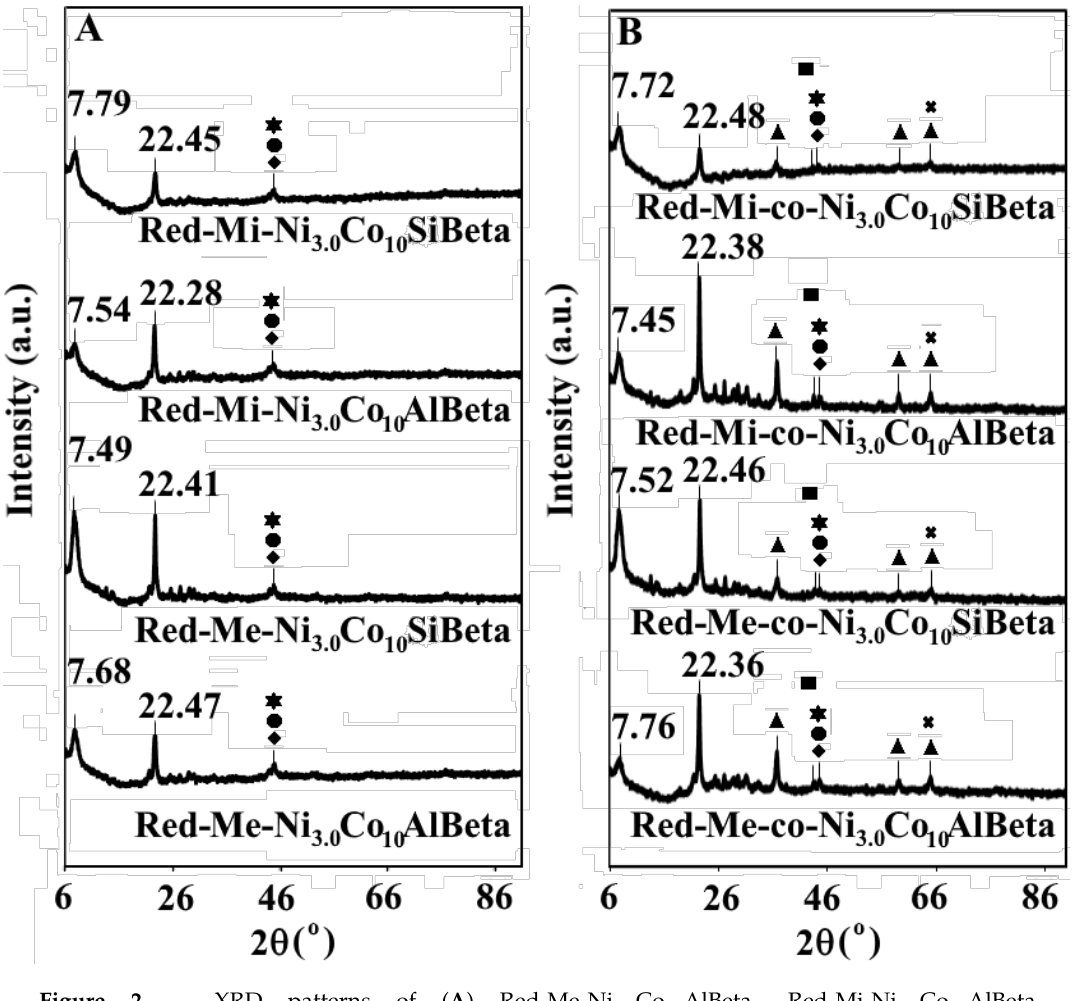
Figure 2. XRD patterns of ( A ) Red-Me-Ni 3.0 Co 10 AlBeta, Red-Mi-Ni 3.0 Co 10 AlBeta, Red-Me-Ni 3.0 Co 10 SiBeta, Red-Mi-Ni 3.0 Co 10 SiBeta and ( B ) Red-Me-co-Ni 3.0 Co 10 AlBeta, Red-Mi-co-Ni 3.0 Co 10 AlBeta, Red-Me-co-Ni 3.0 Co 10 SiBeta, Red-Mi-co-Ni 3.0 Co 10 SiBeta recorded at room temperature and ambient atmosphere ( (cid:7) —Ni 0 , (cid:8) —Co 0 , (cid:86) —Ni-Co alloy, (cid:78) —Co 3 O 4 , (cid:4) —NiO, (cid:54) —NiCo 2 O 4 ).